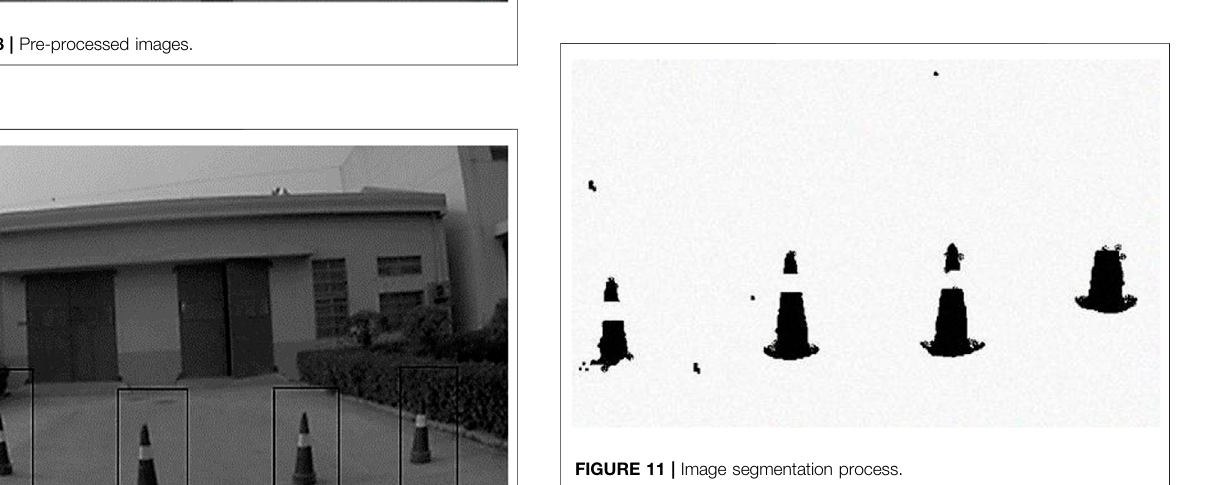
FIGURE 11 | Image segmentation process.